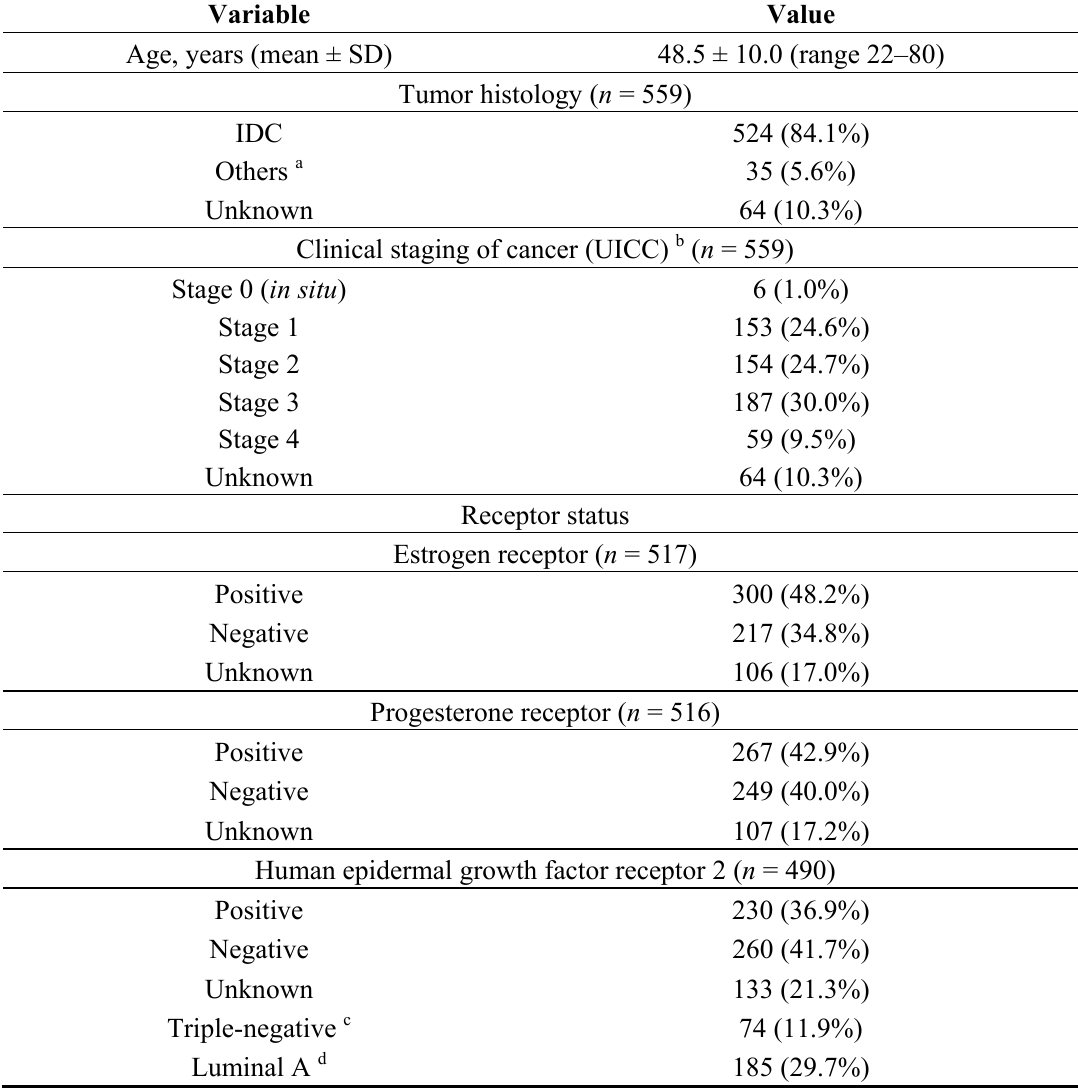
Table 1. Baseline characteristics of select variables in breast cancer cases ( n = 623).